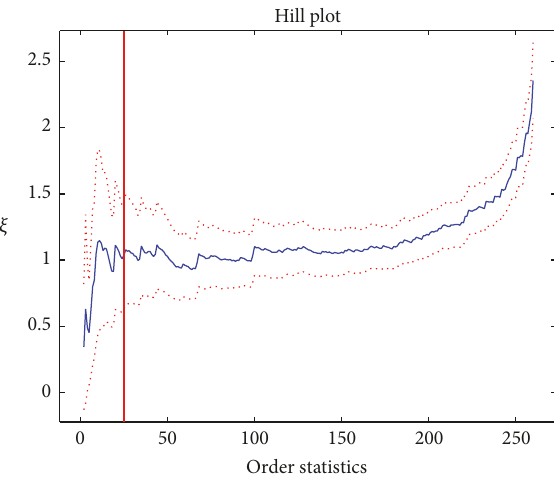
Figure 10: Hill plot versus 𝑘 upper order statistics ( 𝑘 ≤ 260